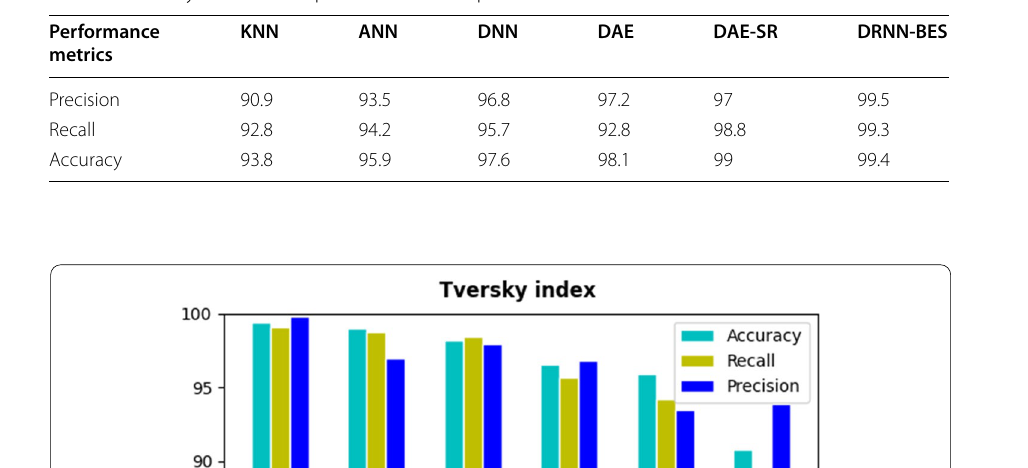
Table 5 Tversky index based performance comparison